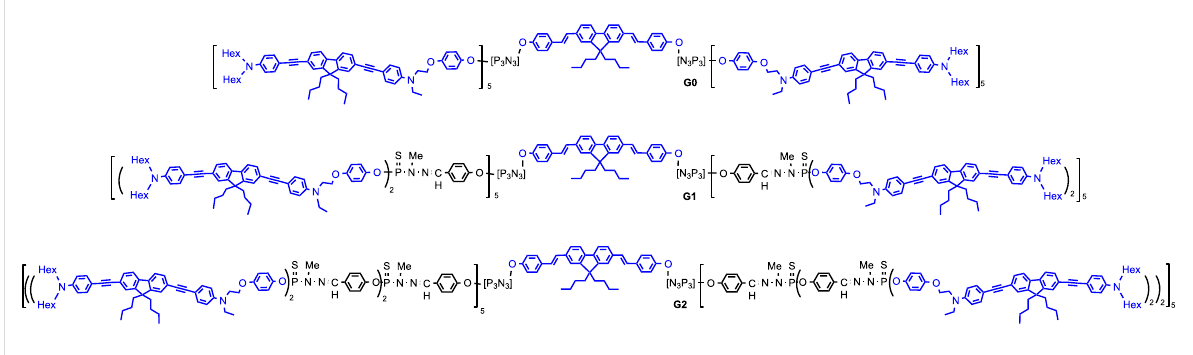
Figure 7: Generations 0, 1, and 2 of dumbbell-like dendrimers having one fluorophore at the core and either 10, 20 or 40 fluorophores on the surface.